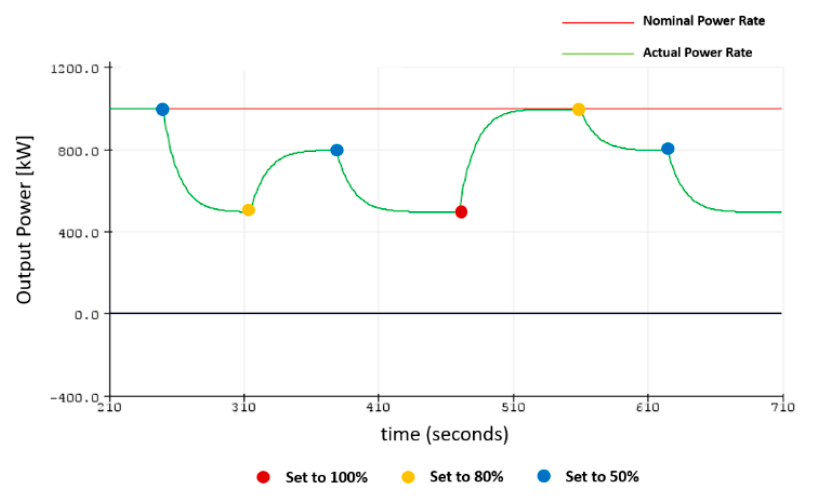
Figure 19. SMRiL output behavior.